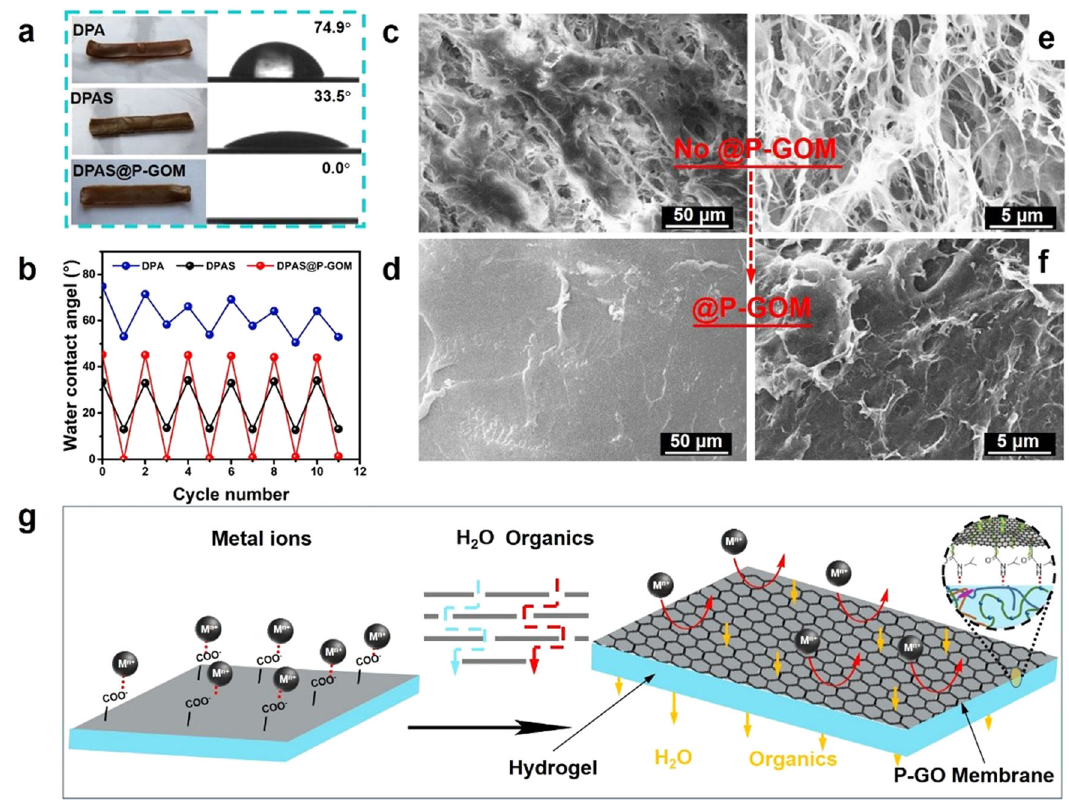
Fig. 4 Wettability and selective ion permeability of the hydrogels. a Photographs showing the wettability of DPA, DPAS, and DPAS@P-GOM (left) and the corresponding water contact angle (right). b Water contact angle (WCA) cyclicity of various hydrogels. SEM images of DPAS hydrogel, c , e unmodi fi ed and d , f modi fi ed by GO immersing in water, and the corresponding enlarged images. g Transport pathways of the water molecules, organics, and